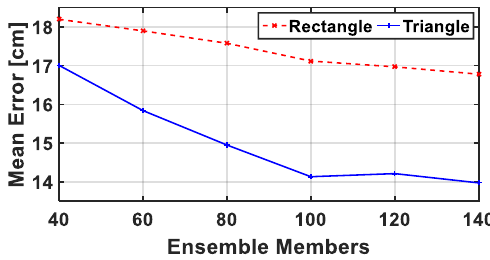
Figure. 4. The relationship between positioning accuracy and ensemble members.